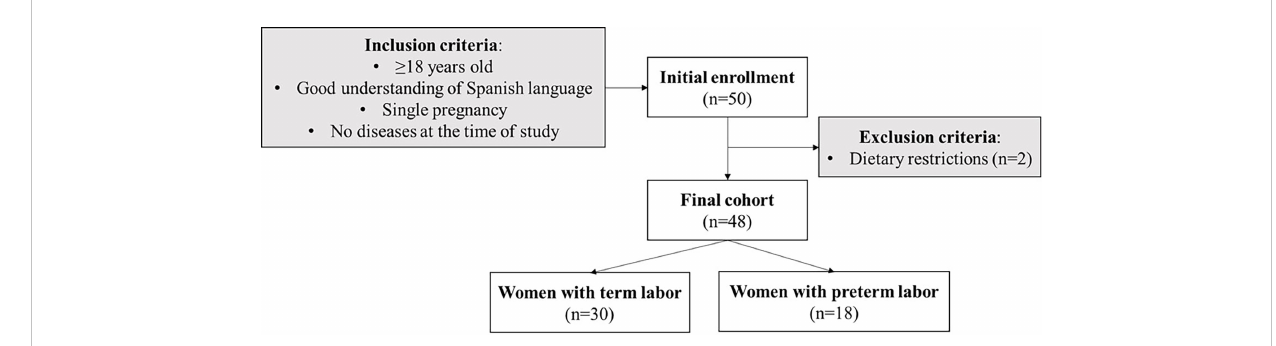
FIGURE 1 Flowchart of the women enrollment in the study and sample size (n) with the inclusion and exclusion